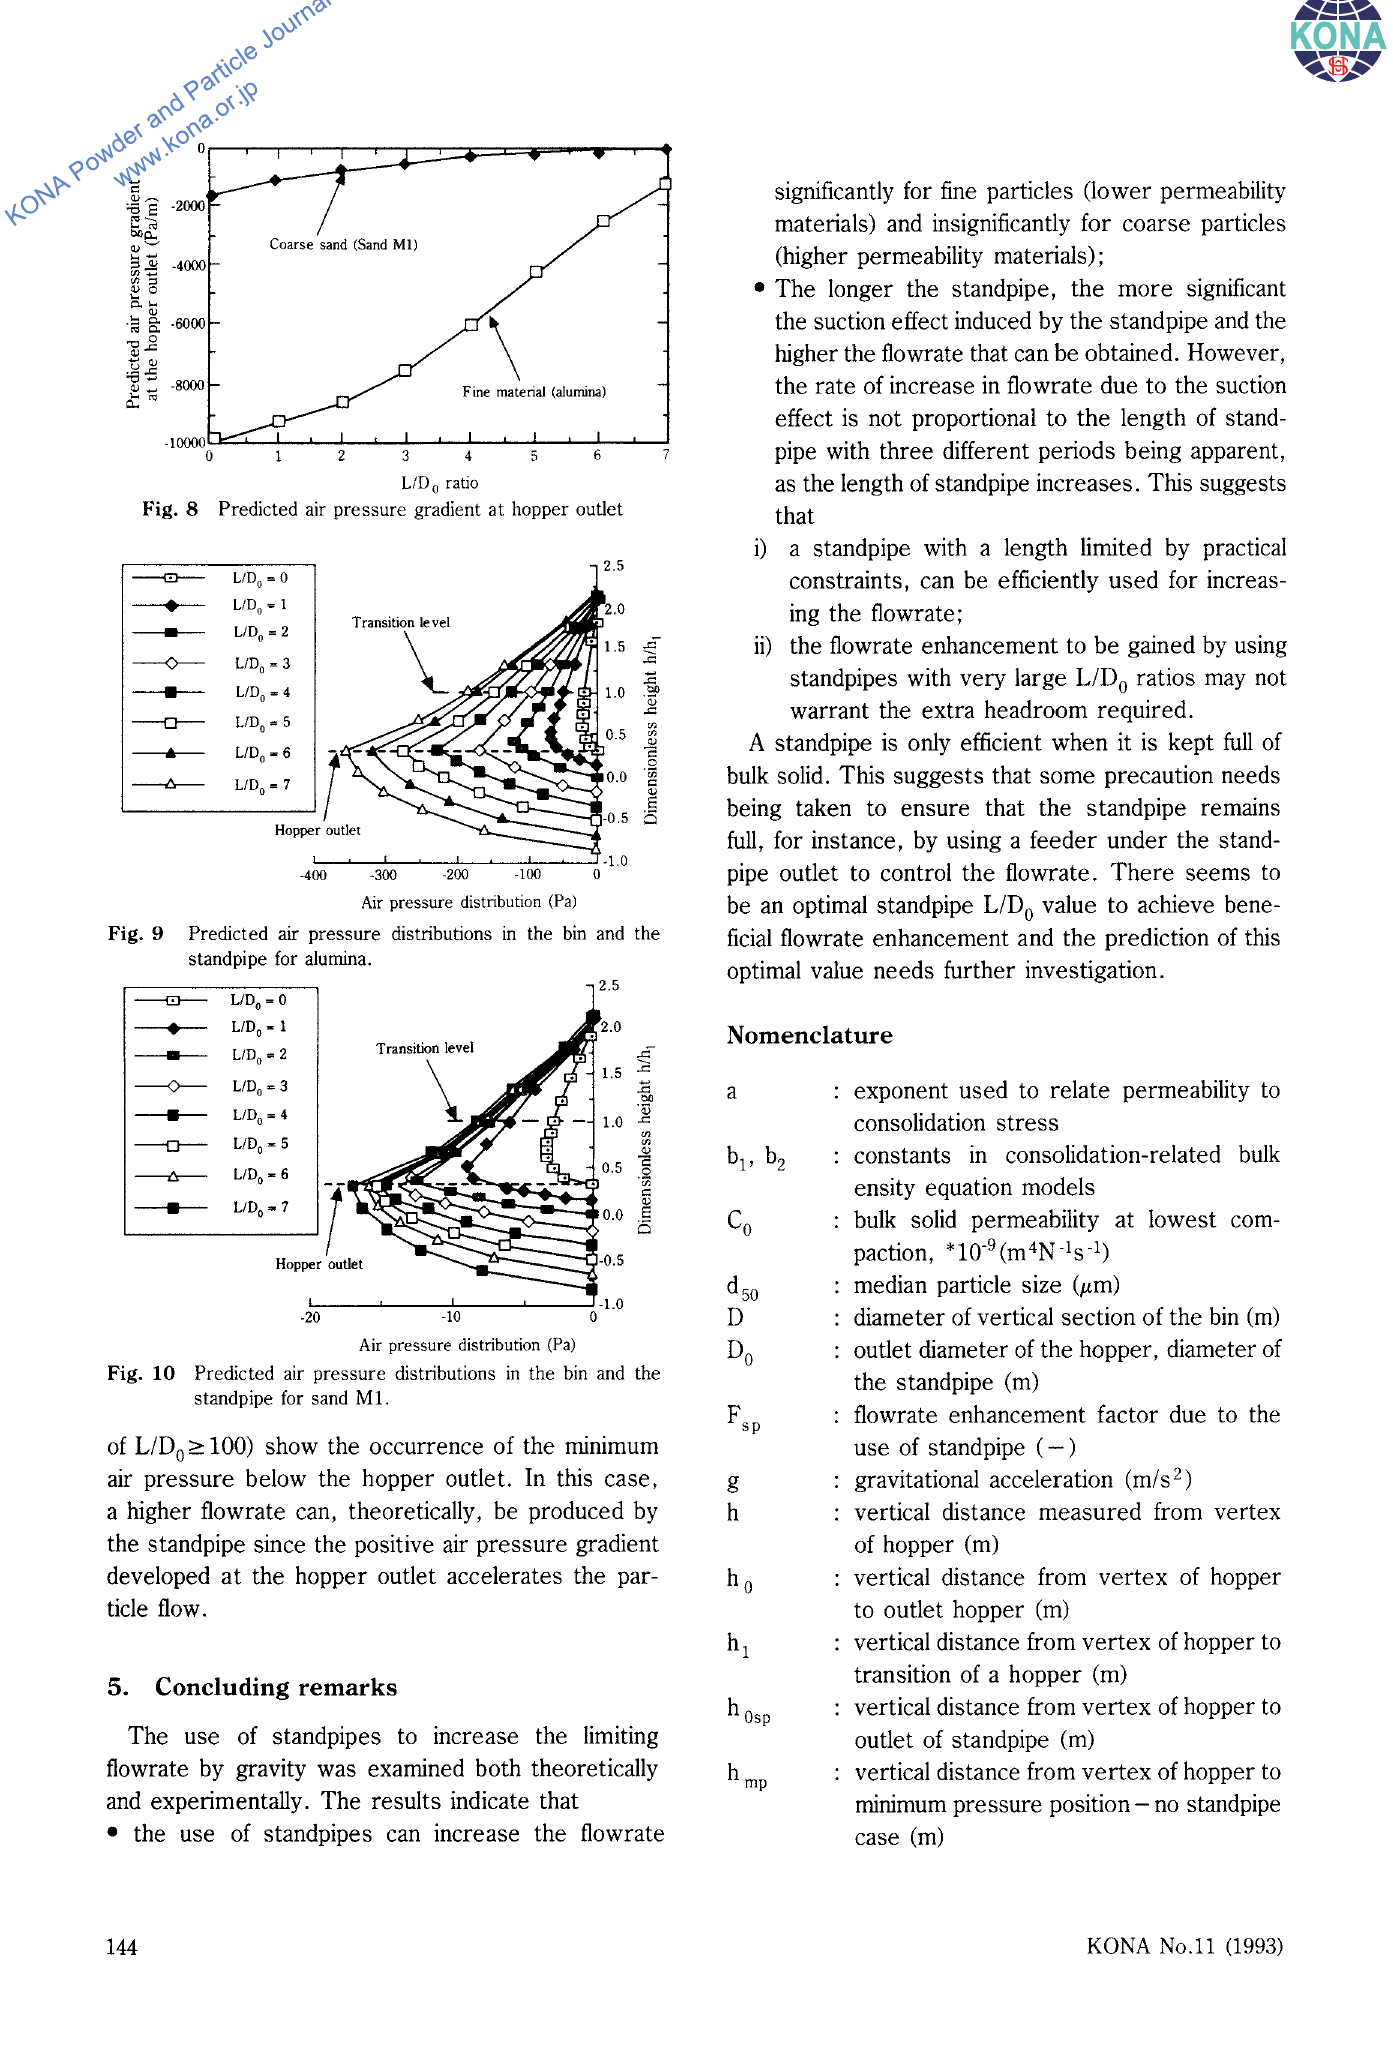
Fig. 10 Predicted air pressure distributions in the bin and the standpipe for sand